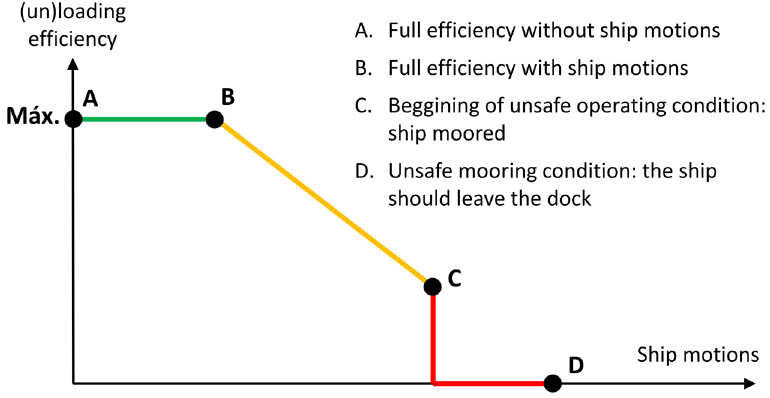
Figure 2. Relation between cargo handling efficiency and ship motions. Adapted from PIANC (1995) [17].